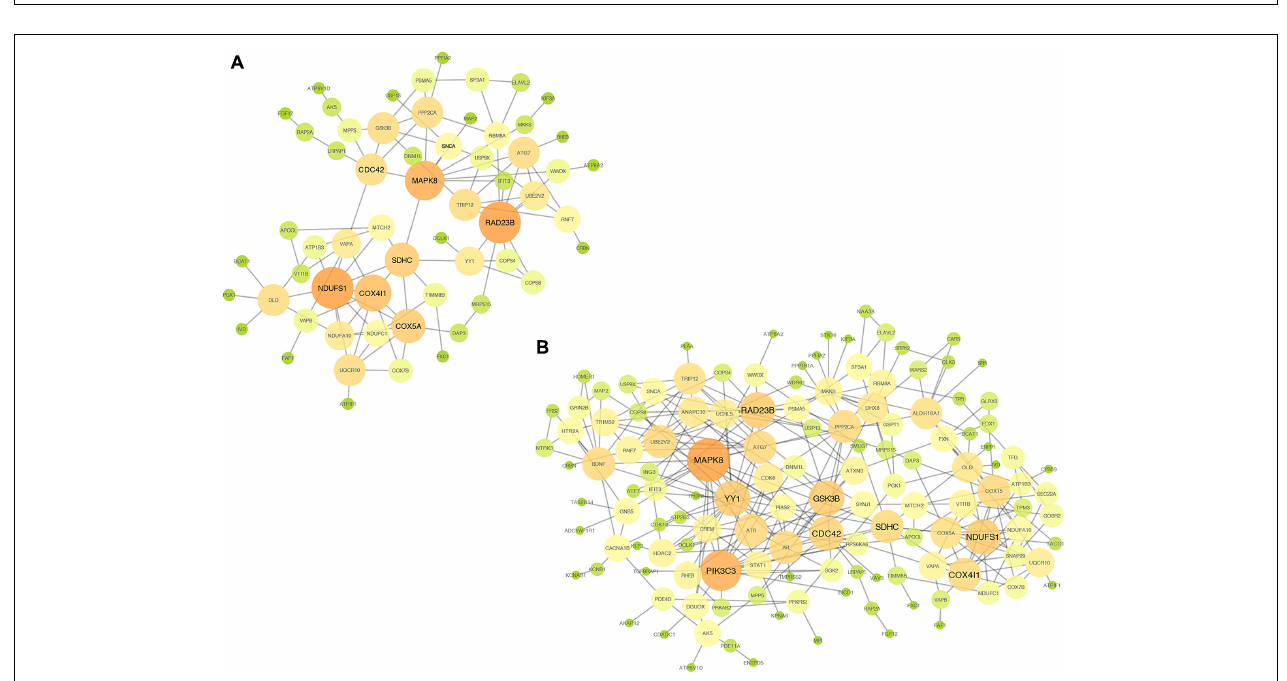
FIGURE 2 | Functional enrichment analysis of meta-DE genes. (A) Cellular components of GO enrichment analysis. (B) Biological processes of GO enrichment analysis. (C) Molecular functions of GO enrichment analysis. (D) KEGG pathway enrichment analysis.